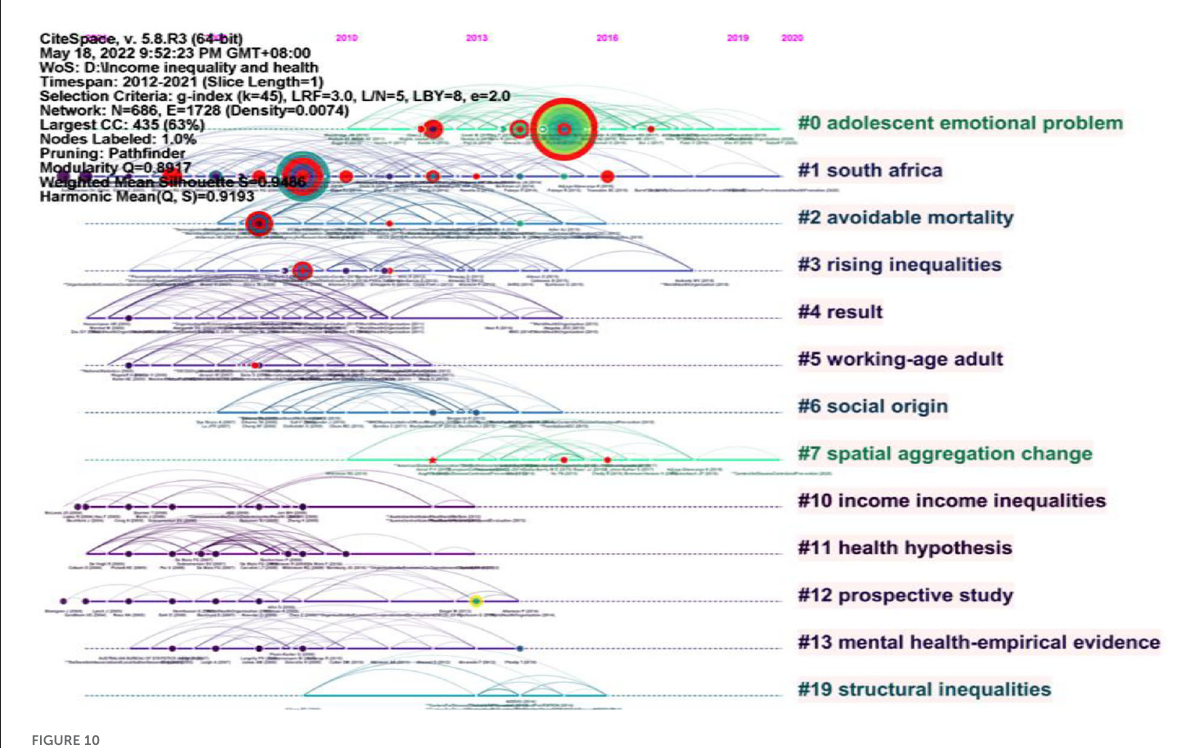
FIGURE10 Timeline visualization of clusters in